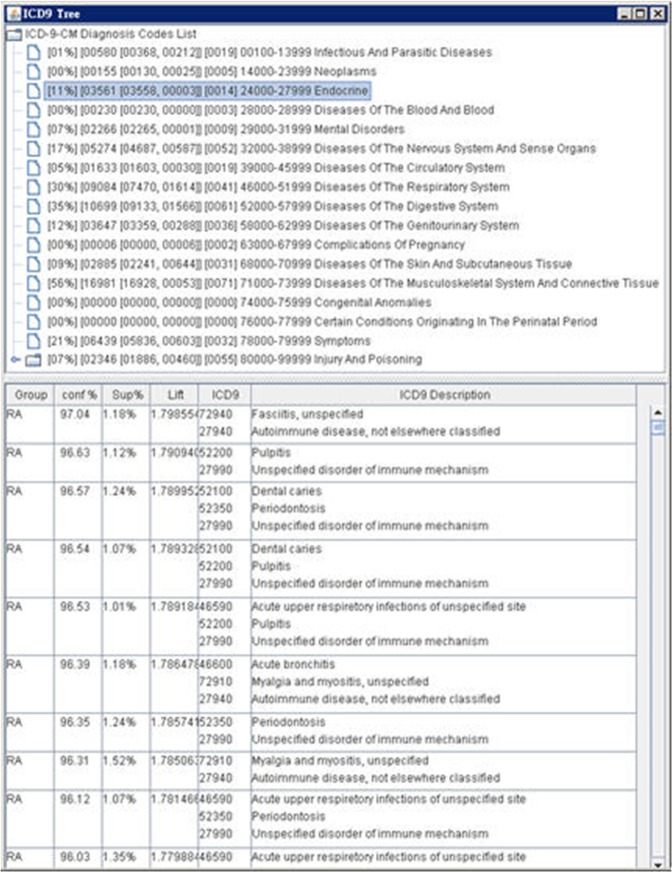
Risk Pattern Viewer.